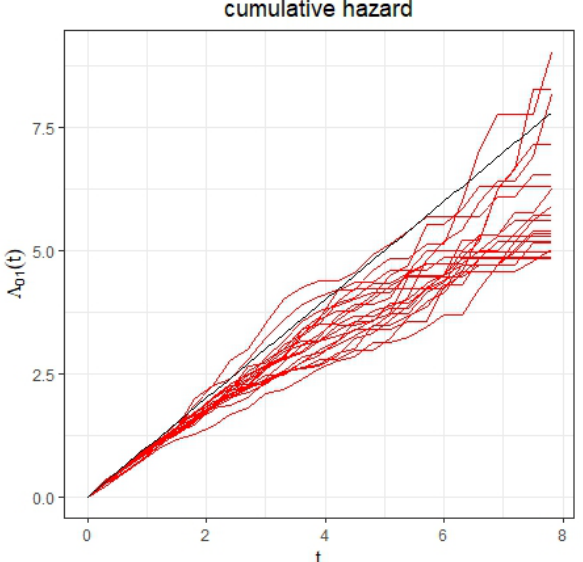
Figure 1. Simulation results for estimated cumulative baseline hazard function Λ 01 ( t ) by the proposed method based on 20 replications (with red color) together with the true cumulative baseline hazard function Λ 01 ( t ) = t (with black color) under the model with gamma frailty in Scenario 1 with sample size 500.